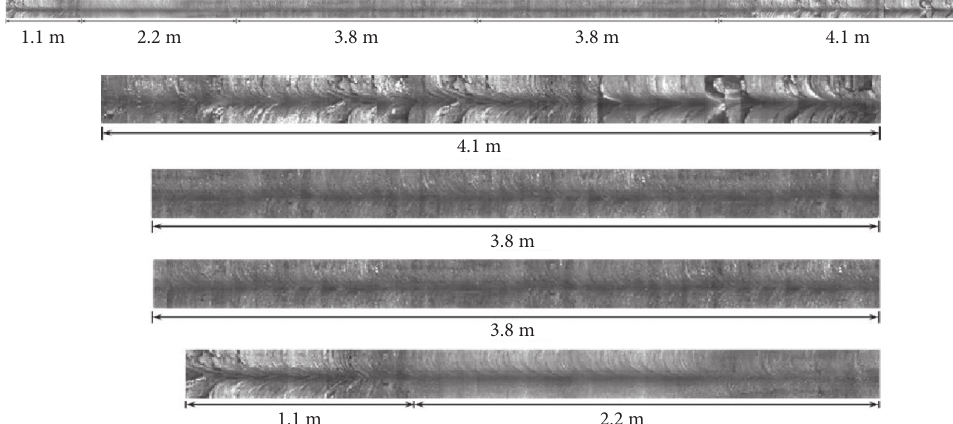
Figure 20: Enlarged borehole camera figure demonstrating rock failure depth [35].